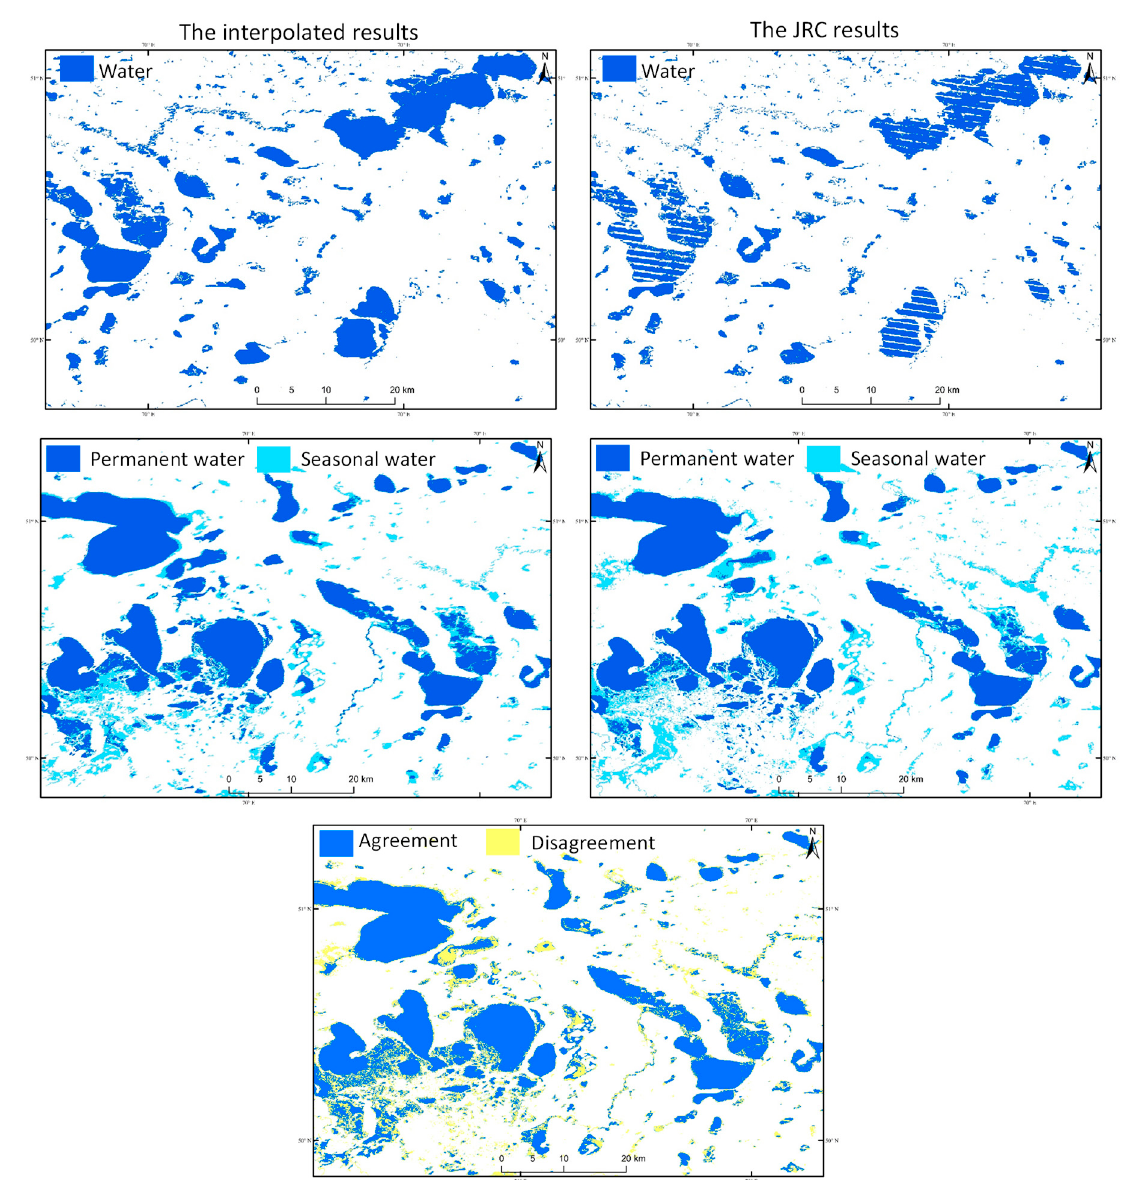
Figure 10. Comparison of the results (first column) to the JRC Yearly and Monthly Water Classification History (second column) as well as the agreement between their yearly datasets (third row) in 2015.